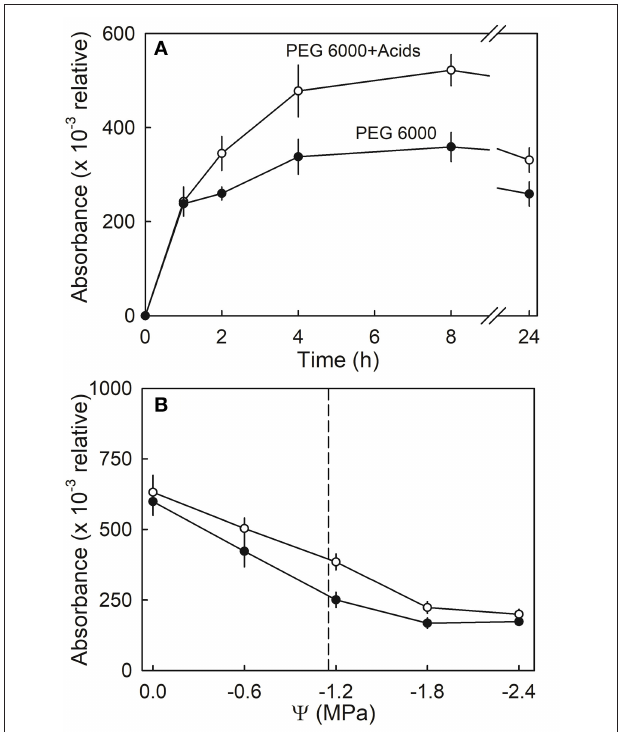
FIGURE 10 | (A) Time course of anthocyanin leakage from flesh disks excised from ripe strawberries in the presence or absence of citric or malic acids. Flesh disks were incubated in isotonic polyethylene 6000 (PEG 6000) solutions. (B) Effect of osmotic potential ( Ψ ) of the incubation solution on anthocyanin leakage in the presence or absence of citric or malic acids. The vertical dashed line indicates the osmotic potential of juice expressed from the fruit of the same